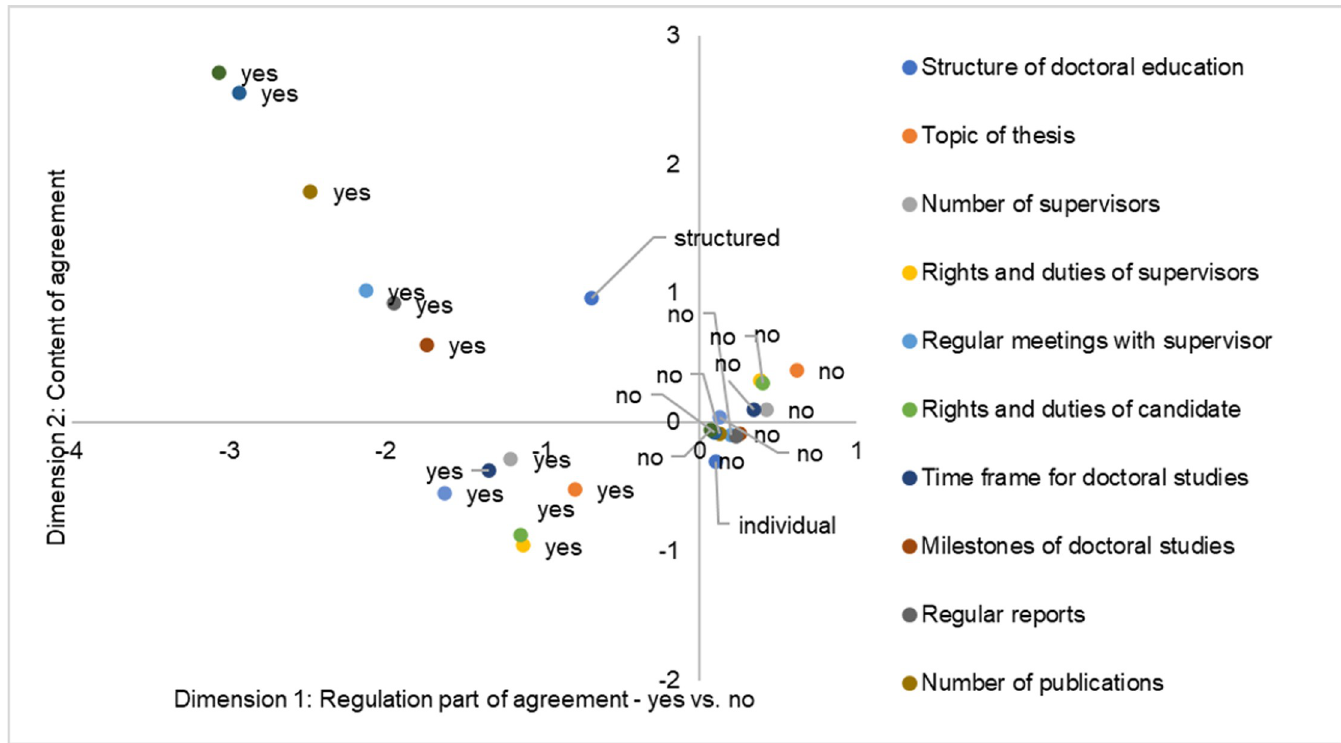
Fig 2. Multiple Correspondence Analysis; regulations on supervision and related aspects that might give structure to doctoral studies, as reported by our respondents; N =